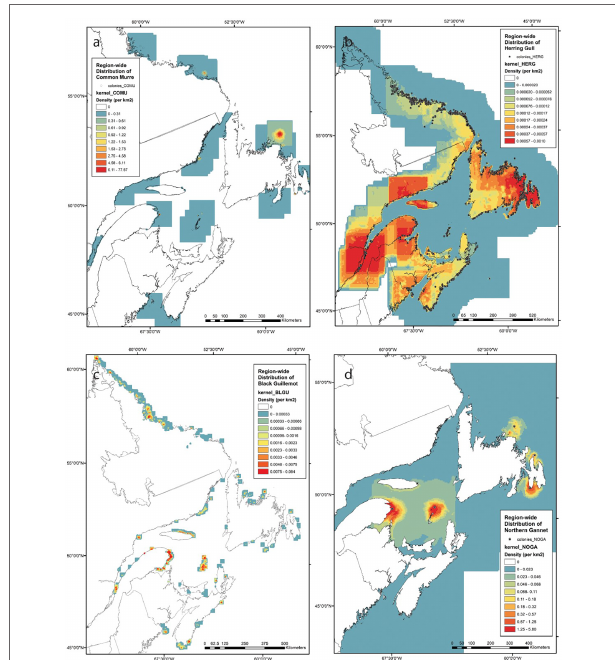
FIGURE 5 | Predictive models of the region-wide distribution of seabird abundance around breeding colonies for (A) common murre (COMU), (B) herring gull (HERG), (C) black guillemot (BLGU), and (D) northern gannet (NOGA). See Supplemental Materials (Figure S2) for maps of other species. Boosted Regression Trees (BRT) were used to model the relative density of tracking locations for each species separately. BRT models were then used to predict abundance distribution, using maximum colony size (based on census data gathered between 1996 and 2016) for each colony, and a kernel smoother applied to estimate abundance distribution